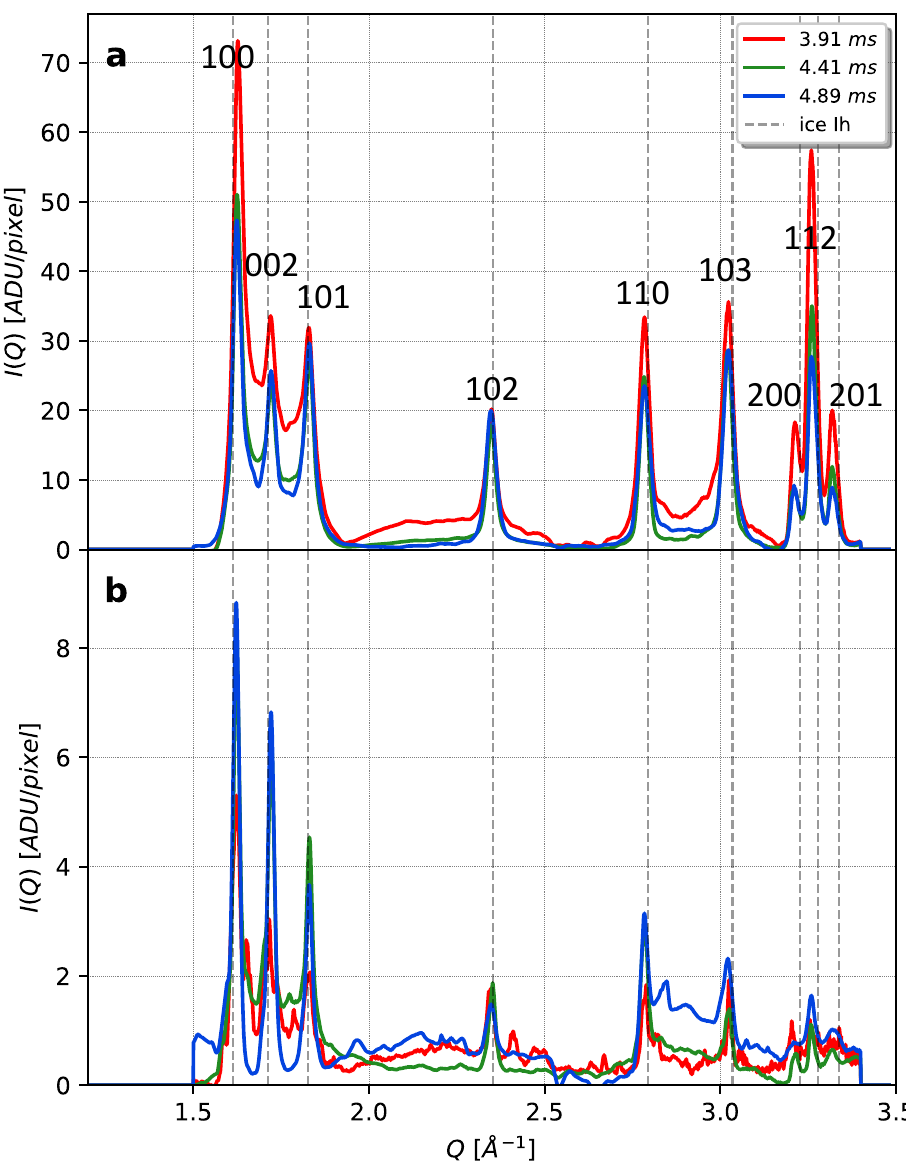
Figure 2. Mean radial WAXS profiles for the ice hits separated into two sub-ensembles based on maximum diffracted intensity in the radial profile. ( a ) The mean radial profiles for hits with a maximum intensity above 50 ADU/pixel show the same hexagonal structure as the overall mean radial profile. We estimate the fraction of cubic ice (and thus cubicity) to be close to ∼ 0% at all travel times. ( b ) The mean radial profile for hits with a maximum intensity between 20 ADU/pixel and 50 ADU/pixel show significantly enhanced (002) peak, indicative of a greater cubic character in the low-intensity ice hits. Estimating the cubicity yields ∼ 9%, 8–20%, 11–26%,